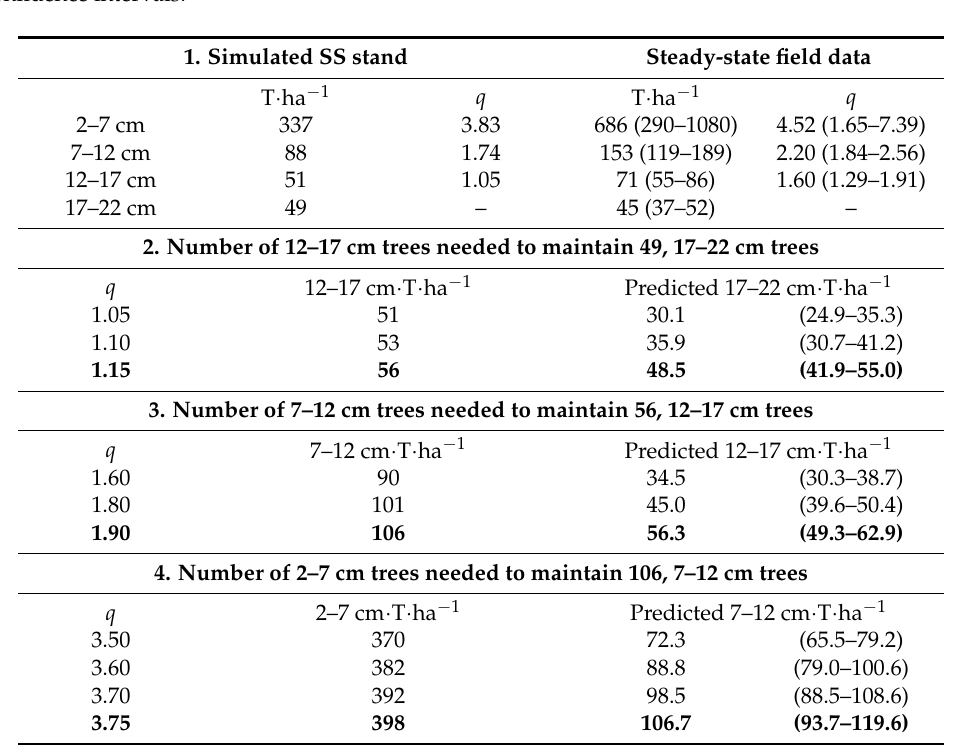
Table 4. Determination of minimum tree densities in the three smallest size classes needed to perpetuate the steady-state structure shown in panel 1. In Panels 2–4, the number of trees in the three smallest 5 cm diameter classes were iteratively adjusted to determine the number of trees necessary to sustain the next larger size class (final result in bold). Simulations were conducted for 500 years, with 20 replicates each, starting from steady-state stands on Acer-Tsuga-Dryopteris (ATD) habitat that developed after clearcut under background mortality only (Group 4 simulations). Numbers in parentheses show 95% confidence